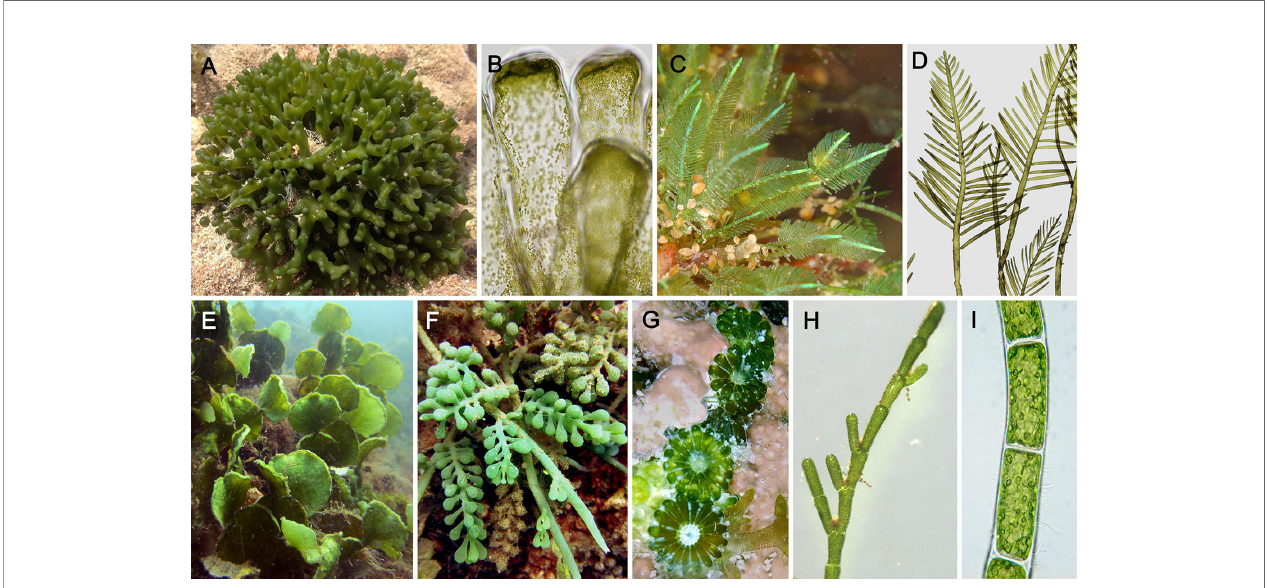
FIGURE 1 | Morphological diversity among coenocytic green algae of the class Ulvophyceae. (A) Codium (Bryopsidales), forming spongy thalli composed of intertwined siphons and an outer layer of vesicles called utricles. (B) Codium , detail of utricles. (C) Bryopsis (Bryopsidales) composed of feather-like siphons. (D) Bryopsis , details. (E) Halimeda (Bryopsidales) forming complex thalli consisting of fl attened calci fi ed segments joint together by non-calcareous joints; segments composed of intertwined siphons and an outer layer of vesicles. (F) Caulerpa (Bryopsidales) forming large thalli composed of stolons anchored to the substrate by rhizoids, and upright photosynthetic fronds. (G) Parvocaulis (Dasycladales), forming thalli similar to Acetabularia , composed of a siphonous stalk and fl attened terminal cap. (H) Cladophora (Cladophorales), consisting of branched fi laments of multinucleate cells. (I) Chaetomorpha (Cladophorales), consisting of unbranched fi laments. [Photo credits: (A) Codium intricatum , by Edward Steven, licensed under CC BY-SA 2.0, https://www. fl ickr.com/photos/138282132@N03/38293915915. (B) Codium vermilara , by Ignacio Barbara, licensed under CC BY-NC-SA 4.0, http://www.marbef.org/modules/photogallery/index.php?album=239&pic=15045. (D – F, H, I) Photo by F.